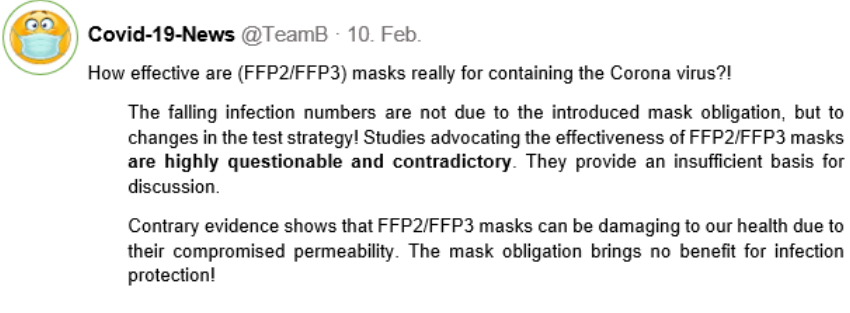
Figure A5. Conspiracy-theoretical Posting Team C Note. Predictor media content: conspiracy-theo- retical Posting Team C. Originally presented in German. Translation; “Die Maskenpflicht von FFP2/FFP3-Masken ist nicht so sinnvoll, wie sie zu sein scheint—vor allem an der frischen Luft ! An der frischen Luft benötigt man keinen Schutz durch das Tragen einer Maske. Es ist sehr unwahrscheinlich sich dort an einer Covid-19-Infektion anzustecken. Das Tragen von FFP2/FFP3- Masken ist dann sogar kontraproduktiv, macht die FFP2/FFP3-Maske unwirksam und behindert die Atmung.“. Figure A6. Conspiracy-theoretical Posting Team F. Note. Predictor media content: conspiracy-theo- retical Posting Team F. Originally presented in German. Translation: “FFP2/FFP3-Masken wirken— schön & gut, aber durch Einwegprodukte, die nicht für alle unbegrenzt zur Verfügung stehen, ist eine Eindämmung der Pandemie auch nur bedingt möglich. Unsere Möglichkeiten FFP2/FFP3-